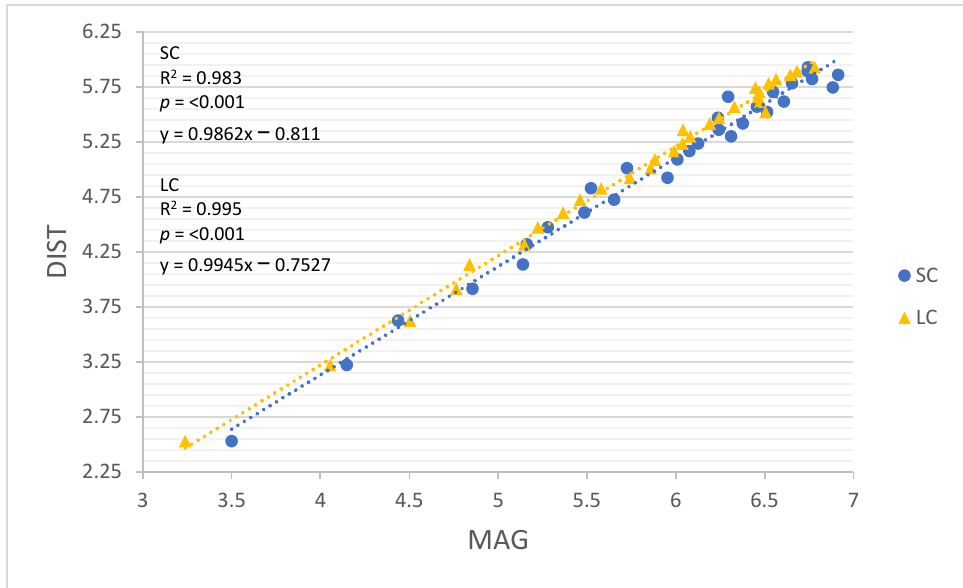
Figure 4. The relationship between log transformed DIST and MAG around the small circle and the large circle. SC = small circle, LC = large circle.